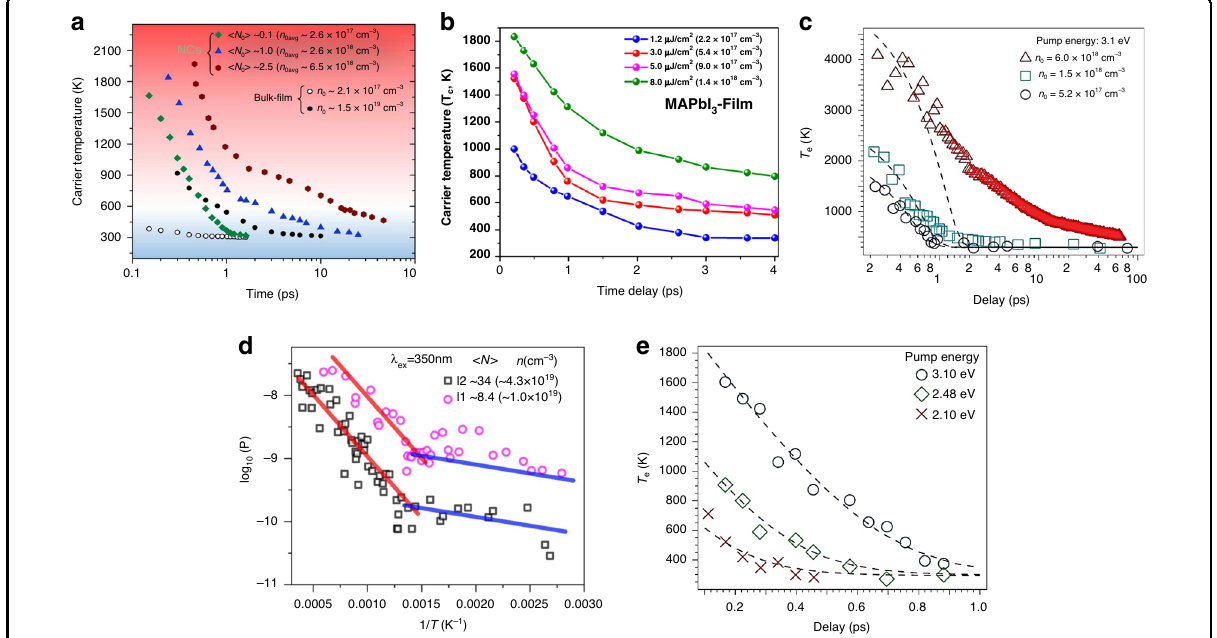
Fig. 9 Effect of charge carrier densities and excitation energy on HC cooling dynamics. a The temperature of HC versus the delay time for MAPbBr3 NCs and bulk fi lm. b , c represent the in fl uence of various excitation densities on HC temperature on perovskite fi lm, where higher initial carrier density corresponds to delay in cooling time. d Power loss in CsPbBr 3 NCs as a function of inverse temperature, where the red line and blue line correspond to HC temperature higher than lattice LO phonons and the equilibrium established between both entities, respectively. e Slow cooling of organic lead halide perovskite in which the in fl uence of various pump energies on HC cooling is observed. Higher energy corresponds to slow cooling. The fi gures are taken with permission from ( a ) ref. 46 , ( c ) ref. 50 and ( d , e ) ref.